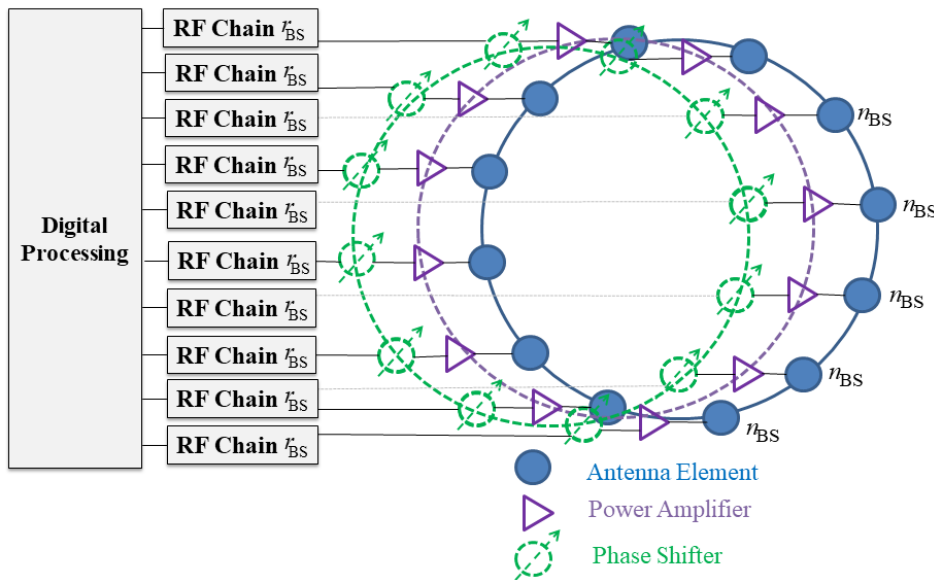
Figure 2. Digital beamformer at the BS.